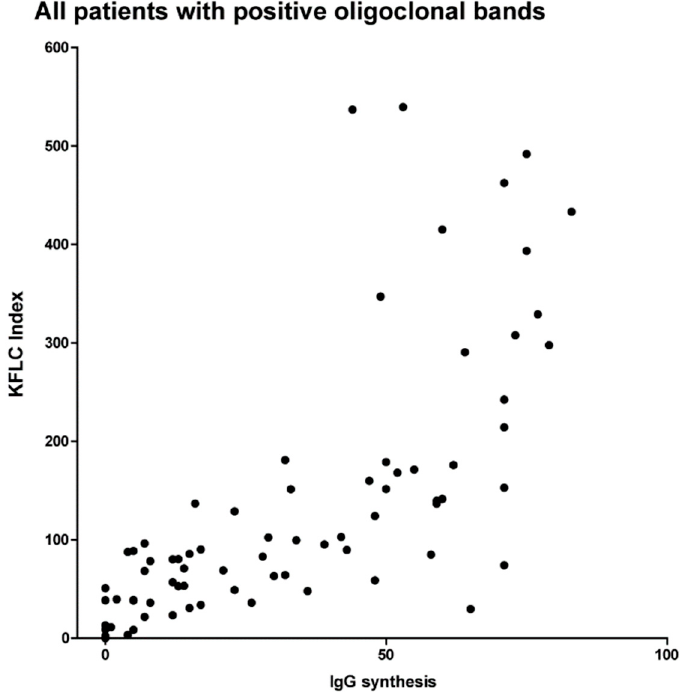
Figure 3. Kappa free light chain indices and quantitative immunoglobulin (IgG) synthesis.